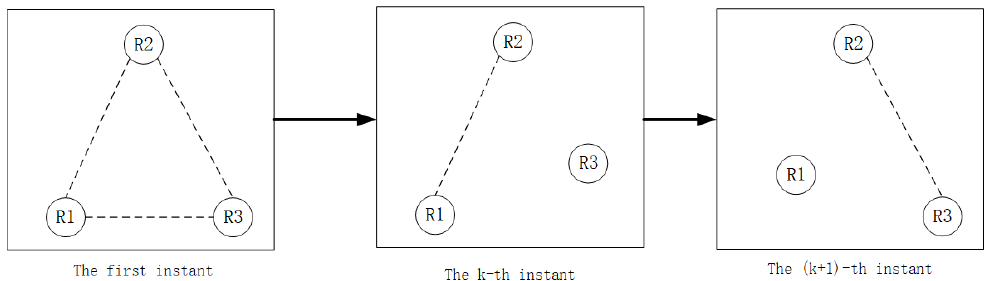
Figure 2. Multi-robot formation with fixed formation.